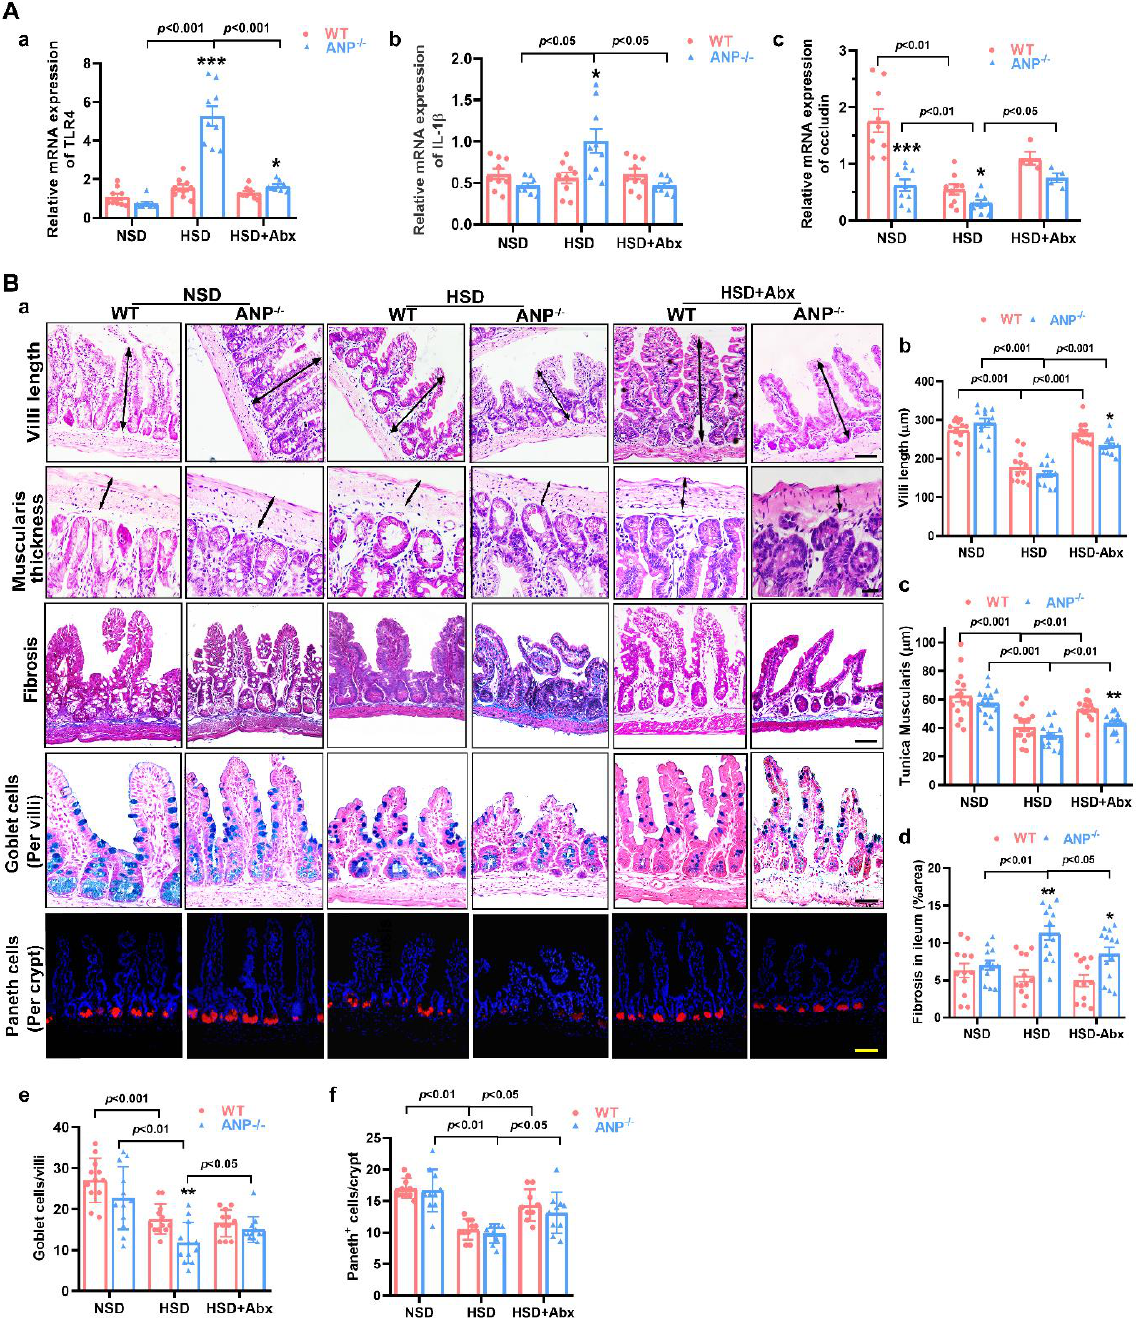
Figure 2. Effects of antibiotics on pathological alterations in the gut of the ANP − / − salt-sensitive model. ( A ) Relative mRNA expression of TLR4 ( a ) , IL-1 β ( b ), and occludin ( c ) in the ileal epithelium ( n = 9). ( B ) ( a ) Cross-sections of the ileum of WT and ANP −/− mice stained with hematoxylin and eosin to measure the villus lengths and thickness of the tunica muscularis layer; Masson trichrome staining to quantify the ileal fibrosis area; Alcian blue–periodic acid–Schiff reagent staining to quantify the number of goblet cells; lysozyme (red) staining at the base of the ileal intestinal crypts in mice to quantify the number of Paneth + cells. Quantitative analysis of villi length ( b ), tunica muscularis ( c ), fibrosis in ileum ( d ), goblet cells/villi ( e ), and Paneth + cells/crypt ( f ). Scale bars = 50 μ m. The p values were evaluated by two-way ANOVA. Significant difference compared to wild type * p < 0.05, ** p < 0.01, and *** p < 0.001 vs. WT.